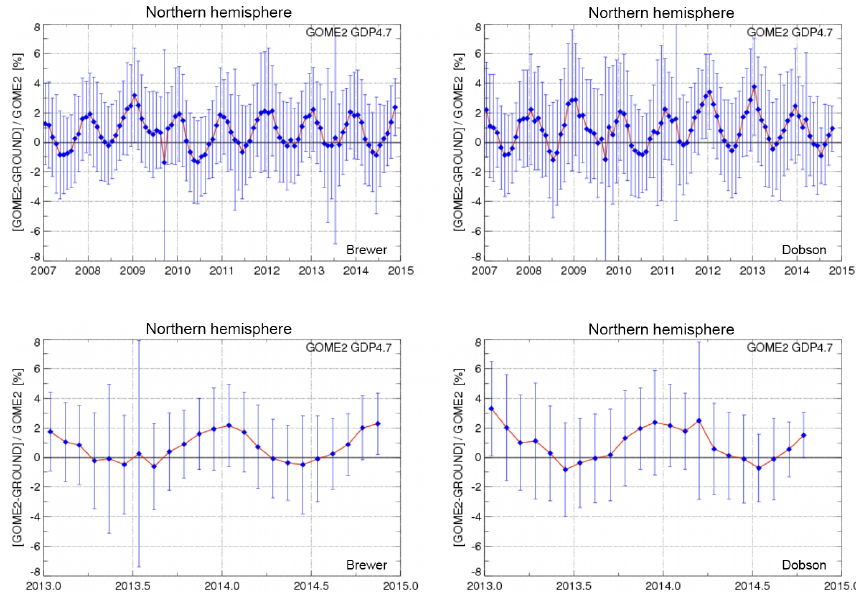
Figure 2. Monthly mean differences between GOME-2A (upper) and GOME-2B (lower) vs. ground-based total ozone columns; Brewer comparisons in the left column and Dobson comparisons in the right.